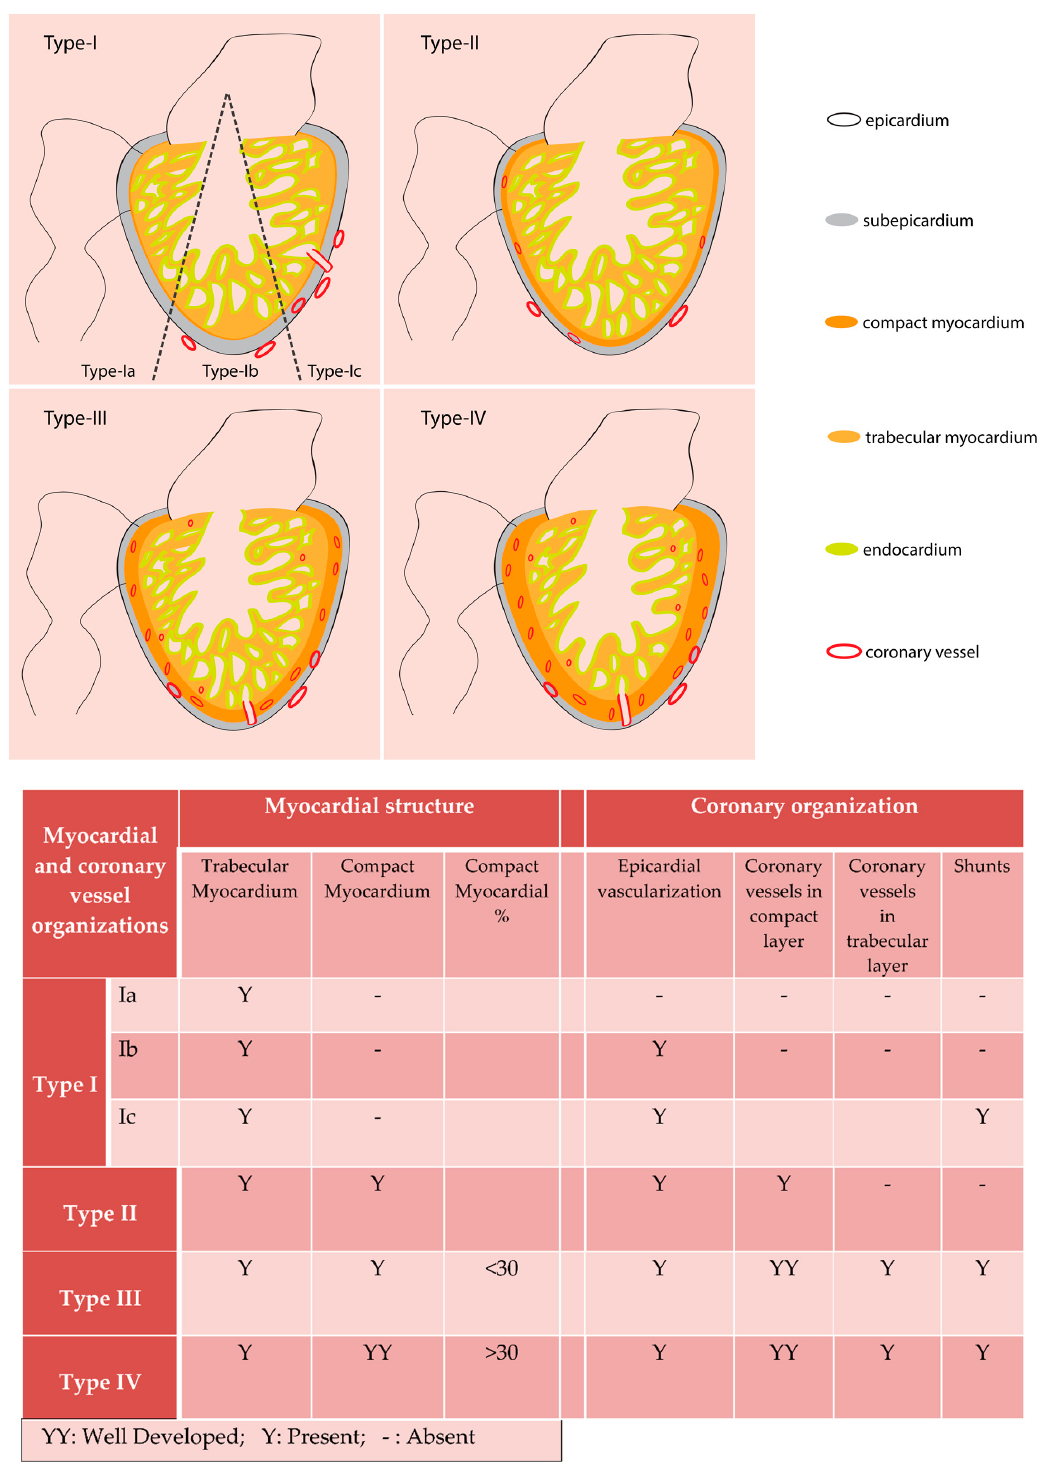
Figure 1. Fish ventricle classification following Tota (1989). Based on cardiomyocyte composition and coronary vessel organization fish hearts are classified into four types. Type I ventricle is mostly made of trabecular myocardium and have superficial epicardial coronary vessels (Type Ib and Type Ic). Type II hearts have ventricles with coronary vessels only in the thin, compact myocardial layer. Type III and Type IV hearts have well developed compact myocardium and have coronary vessel distribution in the compact and trabecular myocardium. Type III and Type IV hearts consist of <30% and >30% compact myocardium